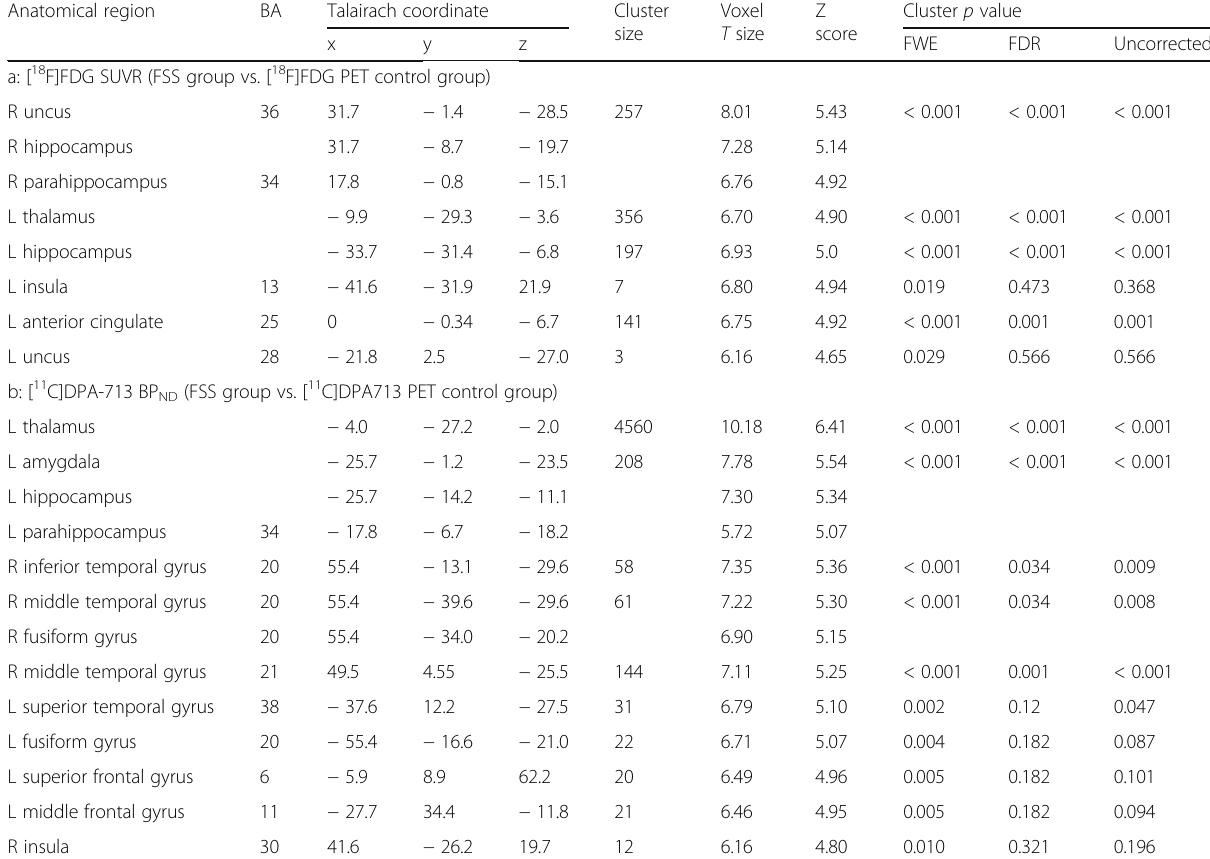
Table 2 Statistical parametric mapping results for [ 18 F]FDG SUVR and [ 11 C]DPA-713 BP